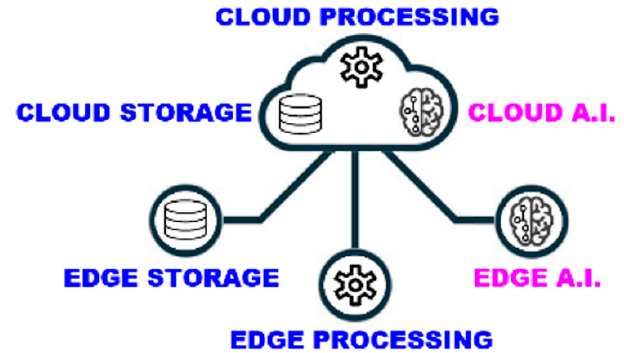
Figure 4. Artificial intelligence (AI) between cloud computing (with blue) and edge computing.